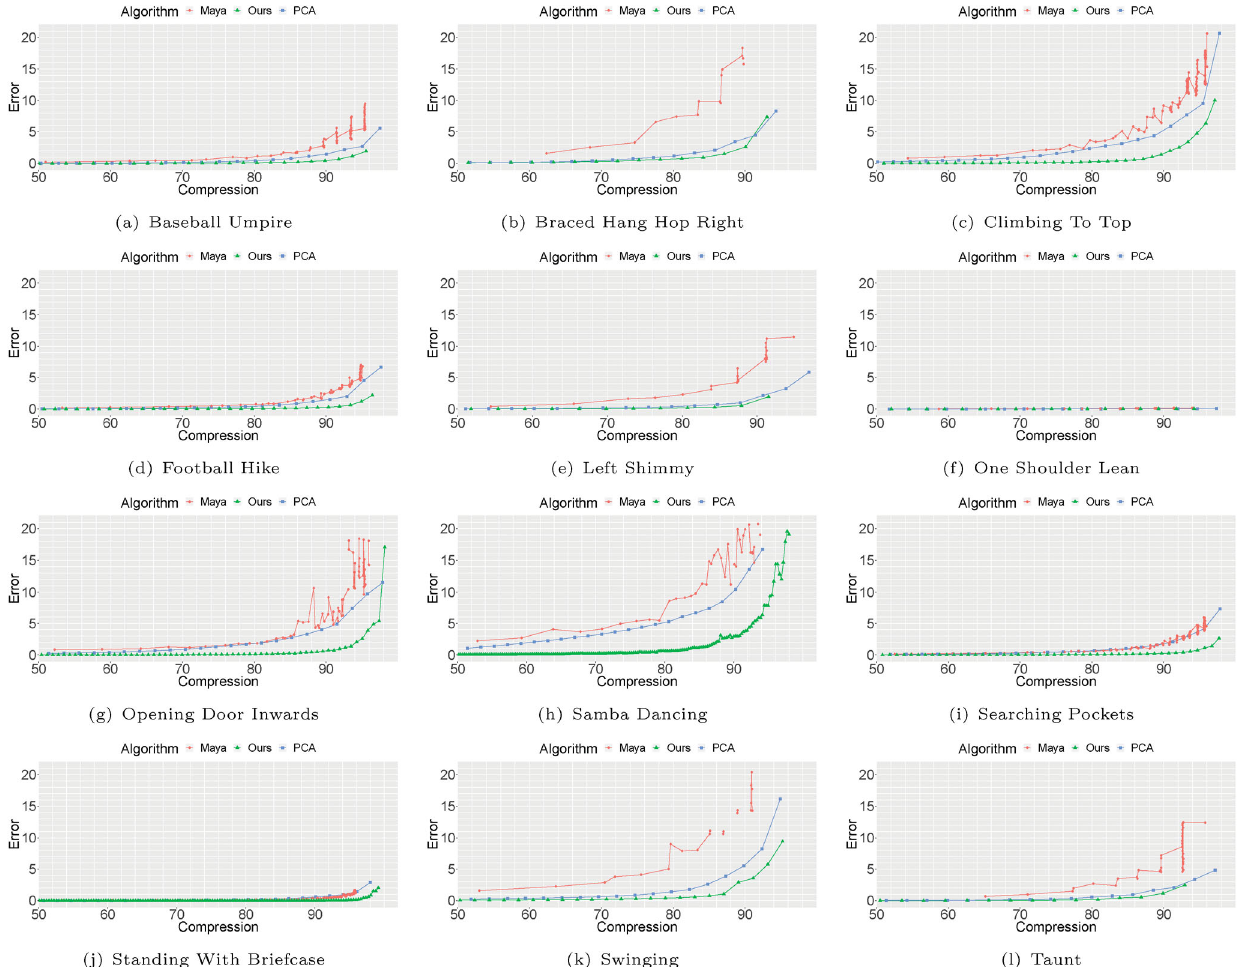
Fig. 12 Comparison between our optimal approximation, our implementation of a pose-based PCA compression algorithm, and Maya’s “Simplify Curves” algorithm. The horizontal axes correspond to the total amount of compression. The vertical axes depict the distance between the original animation and that reconstructed from the compressed interpretation. See Section